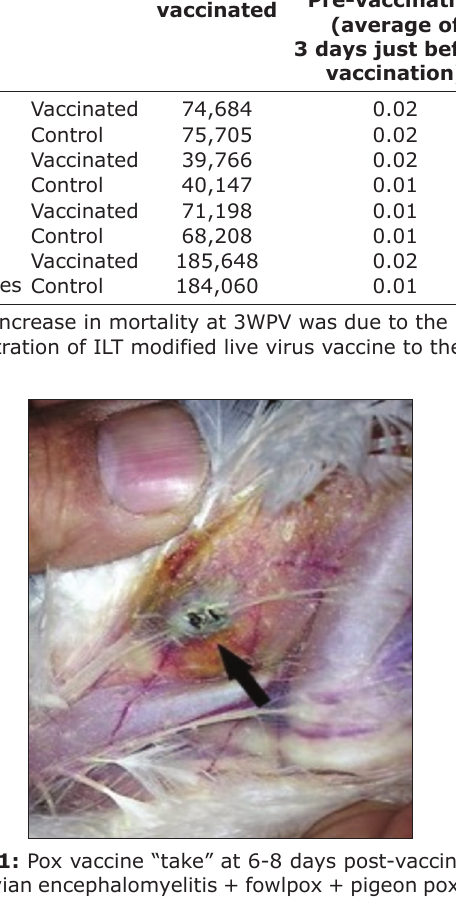
Table-3: Post-vaccination mortality in the AE+FP+PP vaccinated flocks compared to the control flocks. Trial Treatment sites groups